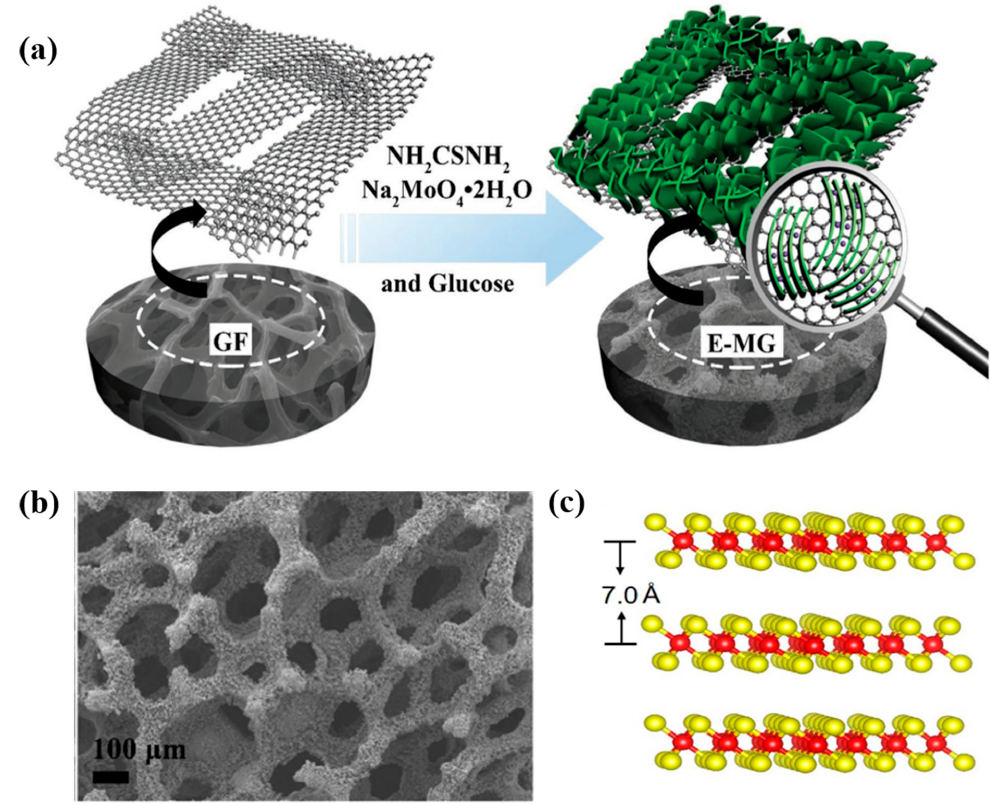
Figure 13. ( a ) Schematic for the synthesis of E-MG. ( b ) Scanning electron microscopy (SEM) image of free-standing MoS 2 /graphene foam. Reprinted with permission from Fan et al. [104] Copyright 2017, WILEY-VCH Verlag GmbH and Co. KGaA, Weinheim. ( c ) The atomic structure with the expanded interlayer distance of MoS 2 . Reprinted with permission from Li et al. [78] Copyright 2018, Elsevier B.V.